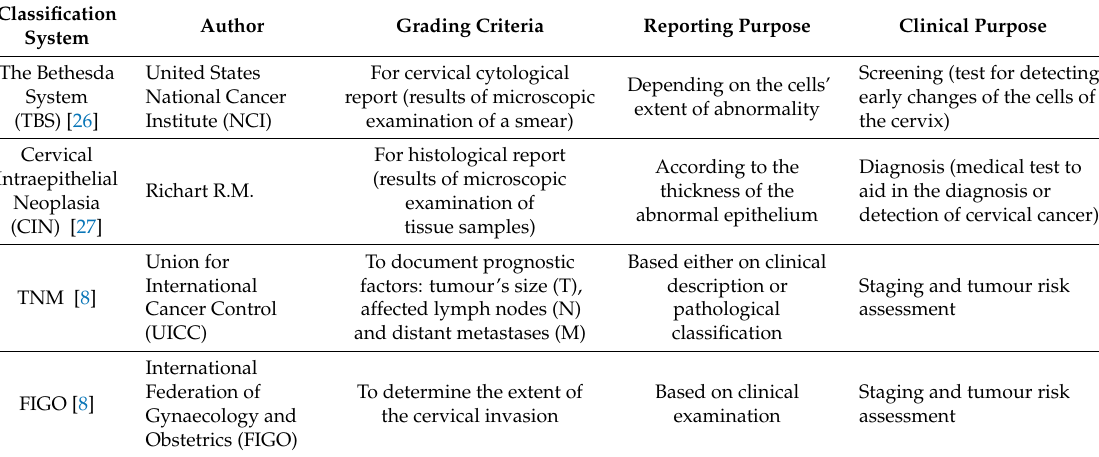
Table 1. Summary information about the main classification systems for cervical